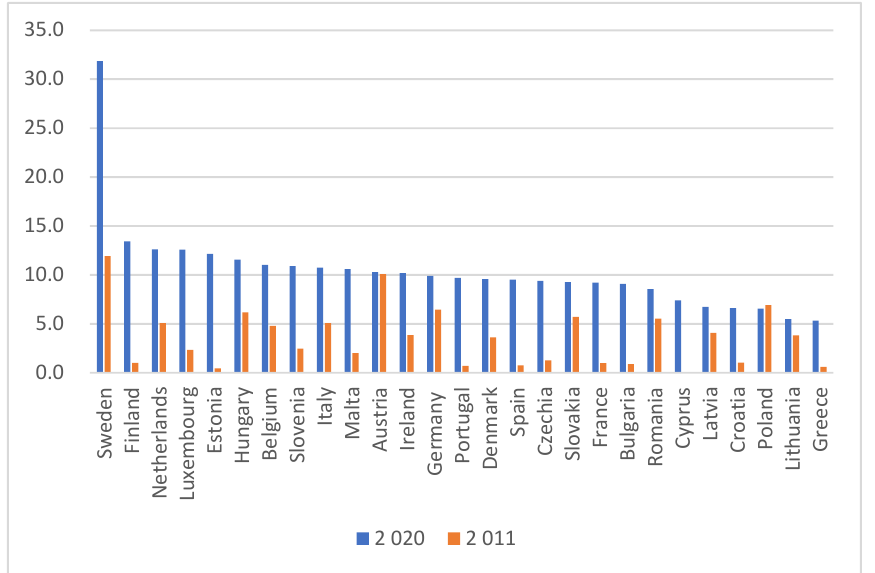
Figure 6. Share of energy from renewable sources for heating and cooling (% of gross final energy consumption).